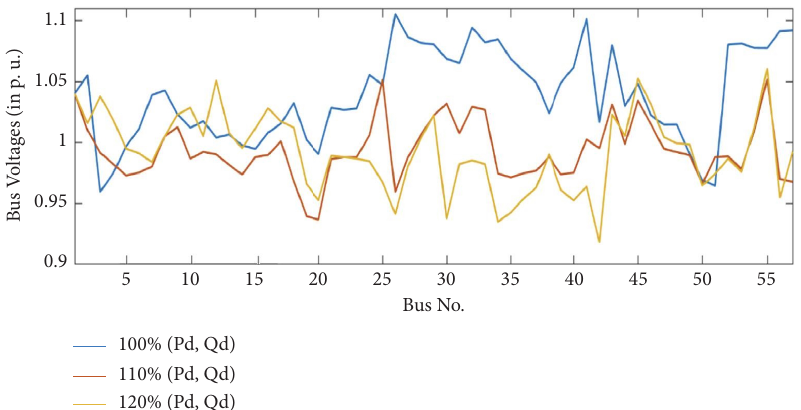
Figure 9: Bus voltage variation at diferent loadings in the IEEE-57 bus system. Table 10: Cost analysis without and with FACTS controllers for IEEE 118 bus system (best values are presented in bold). Loading (P d , Q d ) in %)